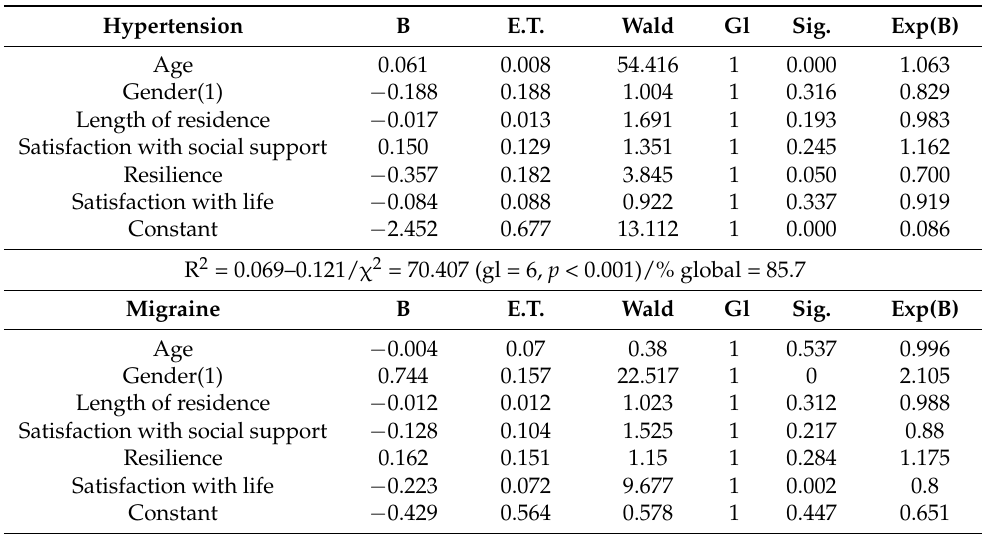
Table 3. Logistic regression analysis of hypertension and